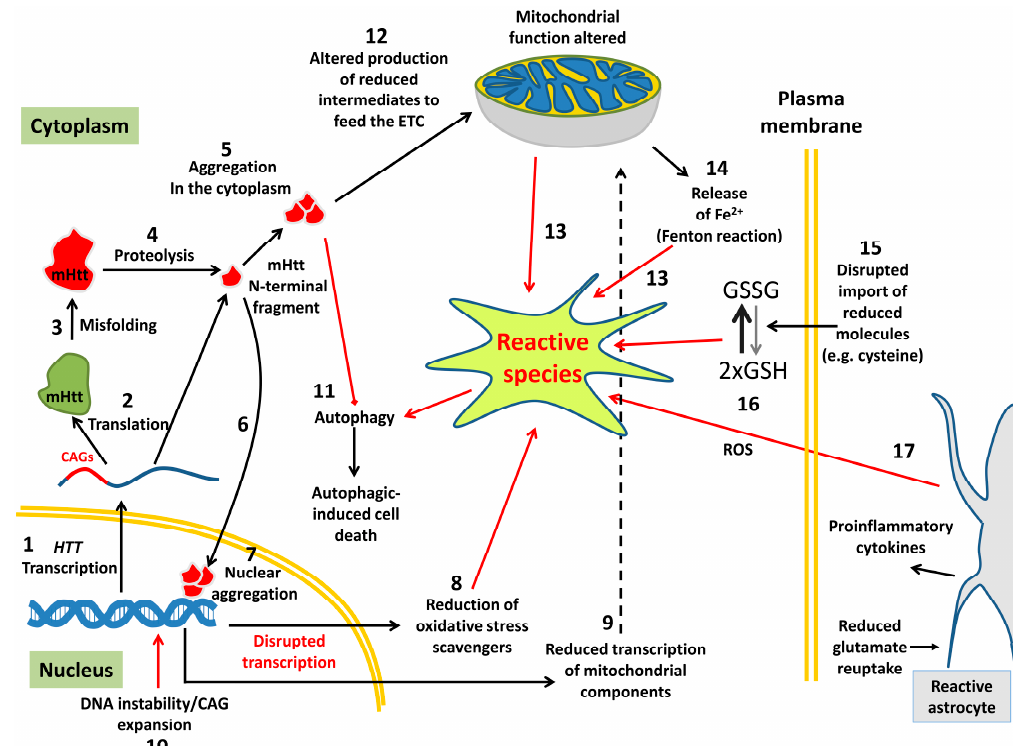
Figure 1. Mutant huntingtin (mHtt) disrupts a series of cellular processes that leads to the production of oxidative stress and produces a series of disruptions in important cellular processes. Once HTT is expressed (1), the messenger is processed through splicing and sent to the cytoplasm for translation (2). The mRNA encoding mHtt contains CAG triplets that can fold in secondary structures and sequester proteins (splicing factors and others), inducing cellular toxicity. Upon translation, mHtt can misfold (3) and become a substrate of proteases (4) which, after digestion, produce different fragments that are very toxic and prone to aggregation (5). These fragments can travel back to the nucleus (6), where they also aggregate (7). These nuclear aggregates can bind different transcription factors, including some genes encoding free radical scavengers (8) and components of the mitochondria (9), which enhances the toxic effects of oxidative stress. Free radicals alter DNA, which causes further expansions of the CAG tandems (10) when the cellular repair machinery opens the damaged DNA. In the cytoplasm, these aggregates interfere with autophagy (11) and the ubiquitin proteasome system (UPS). The aggregates are lipophilic, and therefore able to get between the membranes of the mitochondria (12), causing its malfunction, which in turn produces free radicals (13). Dysfunctional mitochondria liberate free iron (14), which can further induce the production of free radicals through the Fenton reaction. mHtt also causes defects in the plasma membrane (15), which cannot incorporate cysteine, a main component of the glutathione system, to the cytoplasm [14], hence glutathione cannot be reduced (16), enhancing the production of reactive species. Astrocytes respond to neuronal damage becoming activated in the form of reactive astrocytes. These cells produce proinflammatory cytokines and reactive oxygen species (ROS), among other deleterious events, inducing additional damage to neurons, further contributing to this vicious cycle.